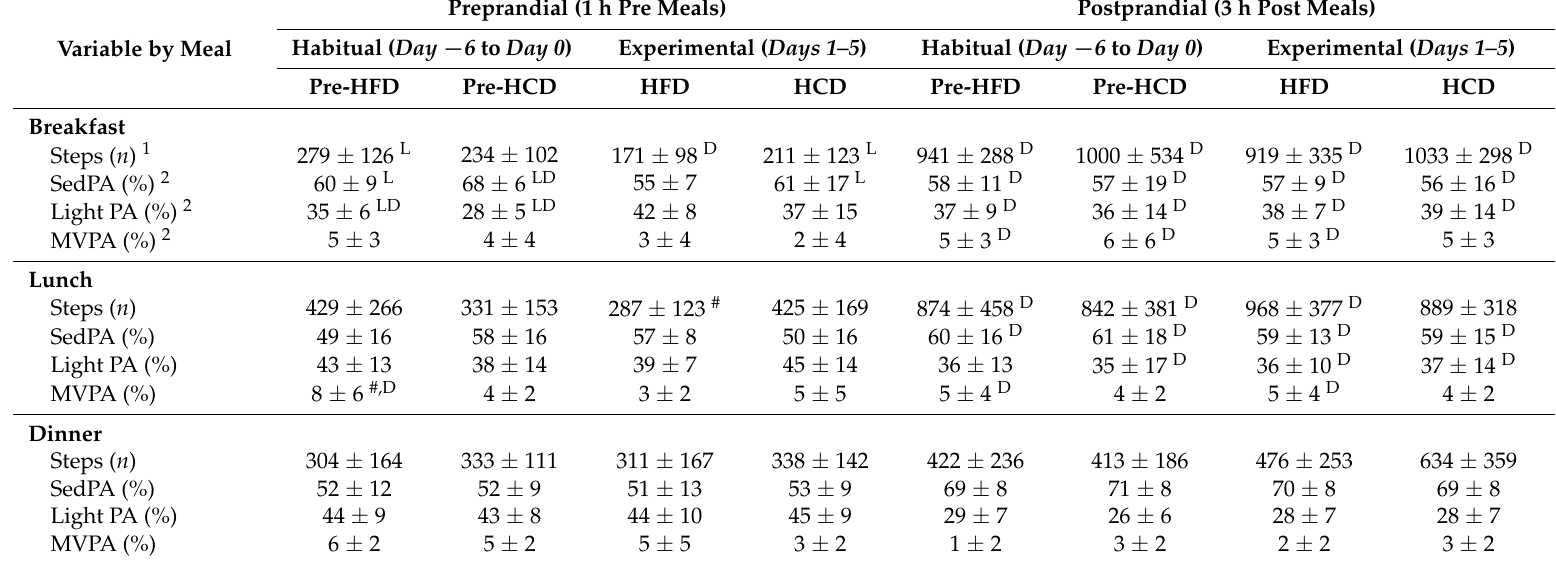
From 1 activPAL and 2 ActiGraph activity monitors where the 1 h pre- and 3 h post-meal periods were analysed as a percentage of valid wear time. MVPA, moderate vigorous physical activity. Data are mean ± SD; using LMM analysis, significantly different ( p < 0.05); # compared to habitual within condition; L compared to lunch within trial; D compared to dinner within